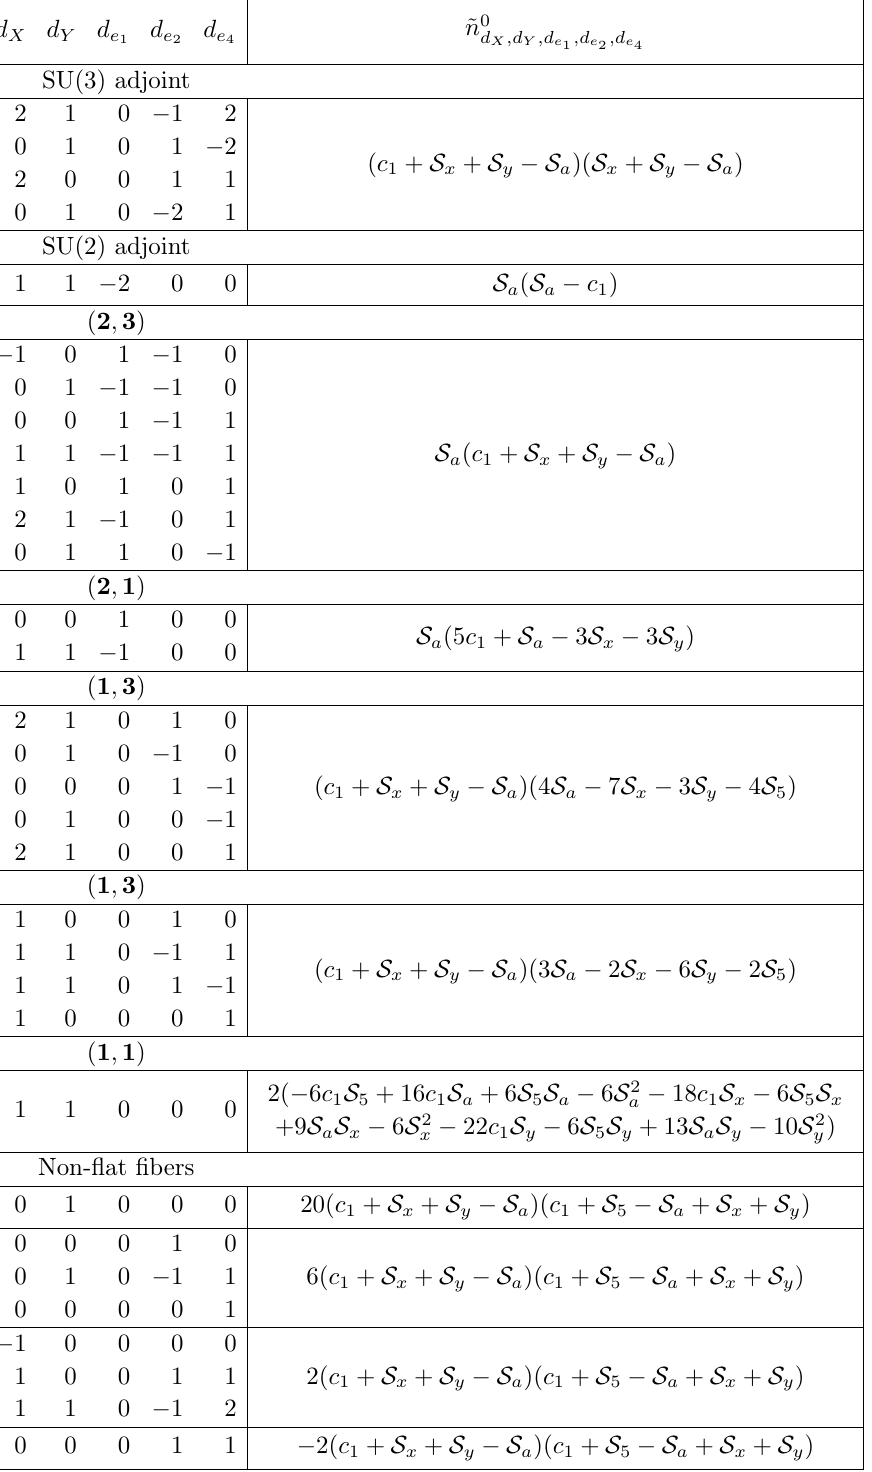
Table 1 . Base independent fiber Gopakumar-Vafa invariants for fibrations with generic fiber real- ized as nef partition (190 ; 2)